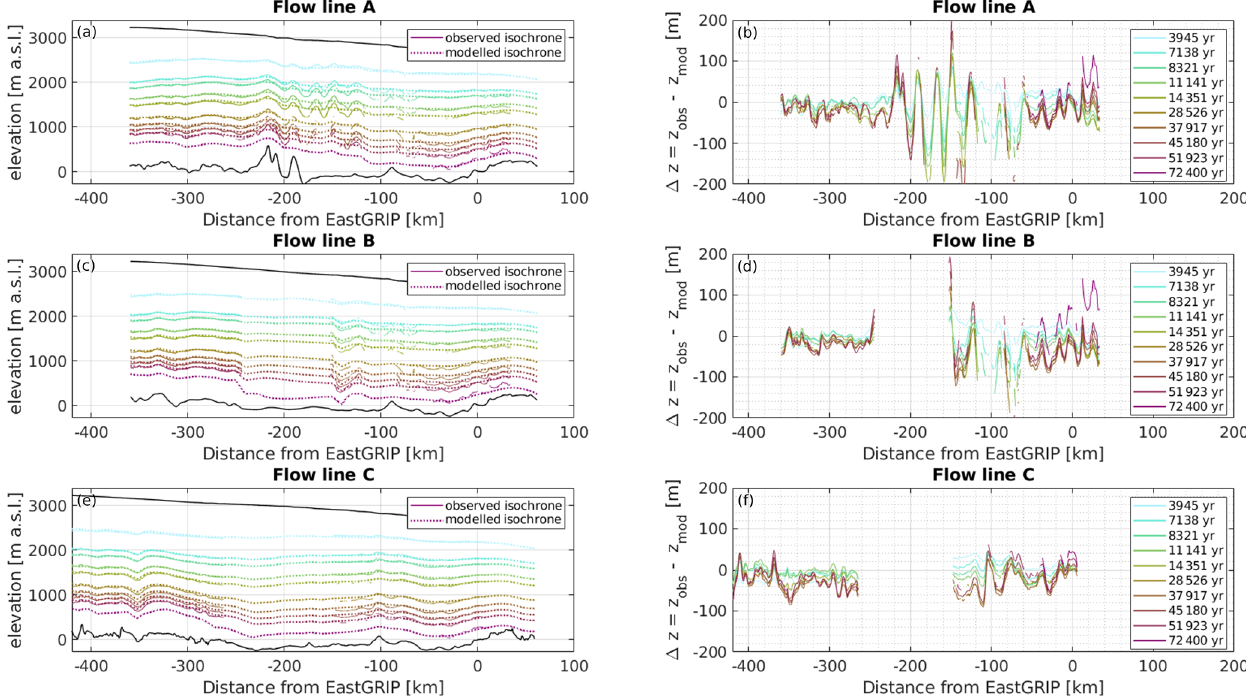
Figure 5. (a, c, e) Modelled and observed isochrones for profile A–C. The model fits the isochrones well in general but fails to reproduce strong layer undulations over short distances, leading to a larger misfit ( b, d, f) where such undulations are present. A positive misfit indicates that the modelled isochrone depth is overestimated which happens in particular for the deepest isochrone towards the end of flow line A and B. As in Figs. 4 and 7, the colour code represents the age of the corresponding